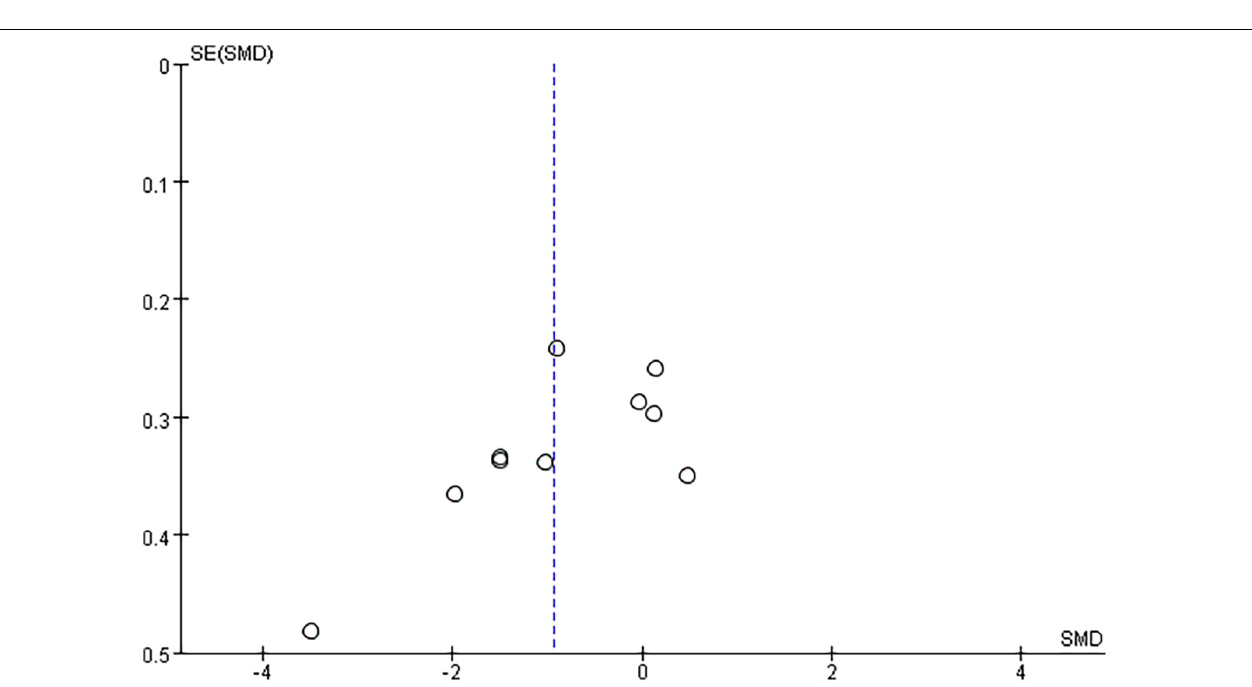
FIGURE 4 | Funnel plots for the effect of Cognitive function. Blue color dotted line, the combined standardized mean difference (SMD) value.